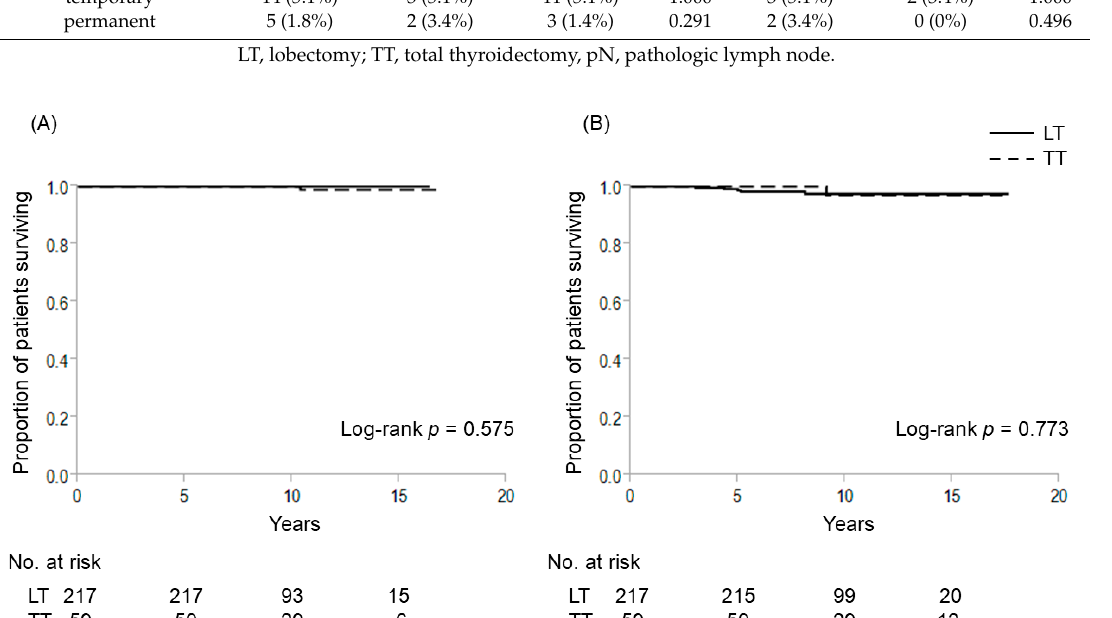
Figure 5. Cause-specific and disease-free survival curves for patients without TERT promoter mutations who underwent lobectomy and total thyroidectomy after propensity score-matching for patients with intrathyroidal PTC with a maximal diameter of 1–4 cm. ( A ) Cause-specific survival; ( B ) disease-free survival. LT, lobectomy; TT, total thyroidectomy.